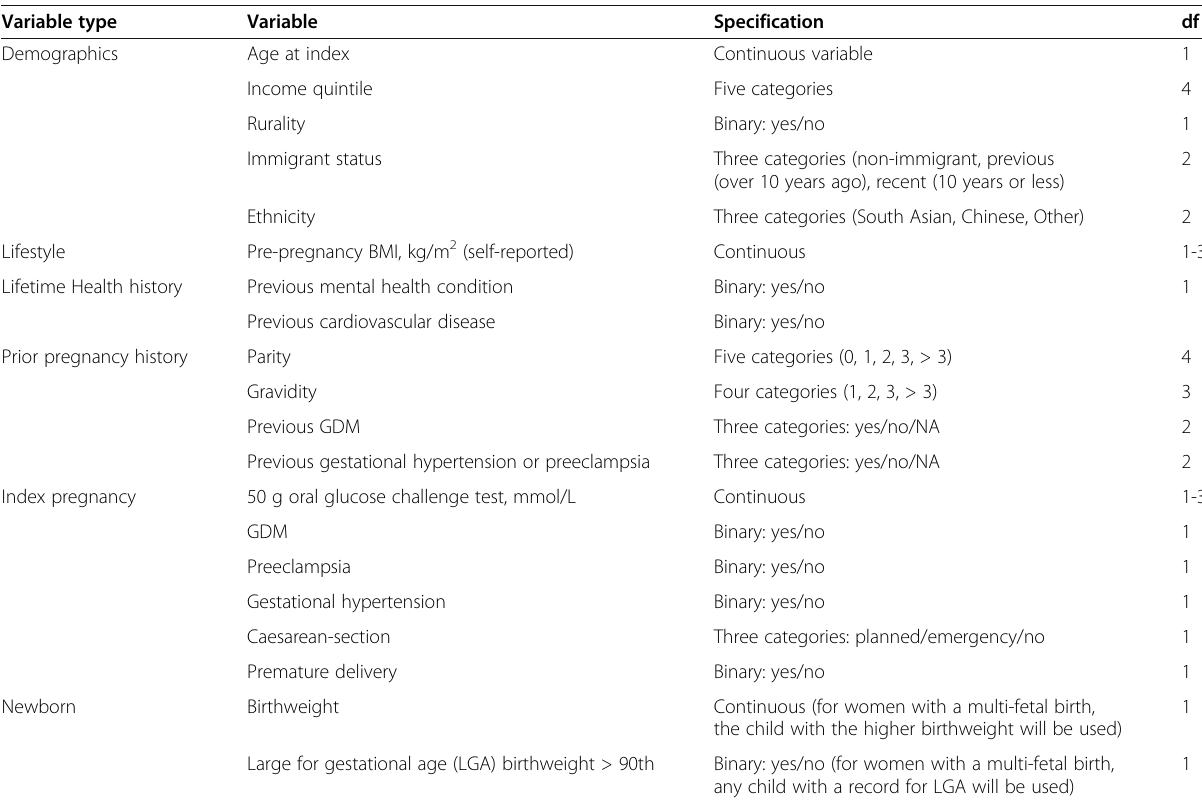
Table 1 Pre-specification of predictors for risk prediction model Variable